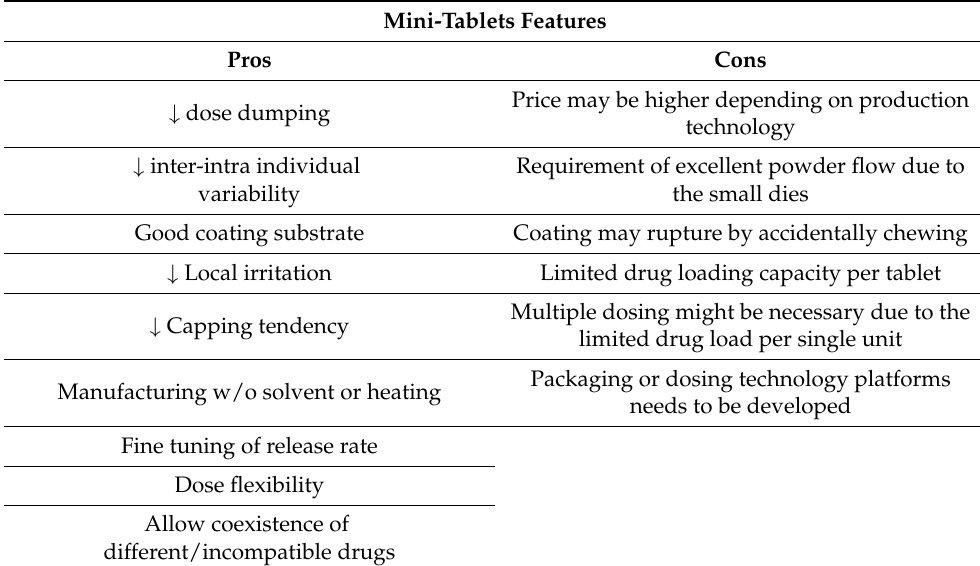
Table 3. Main advantages and disadvantages of mini-tablets.